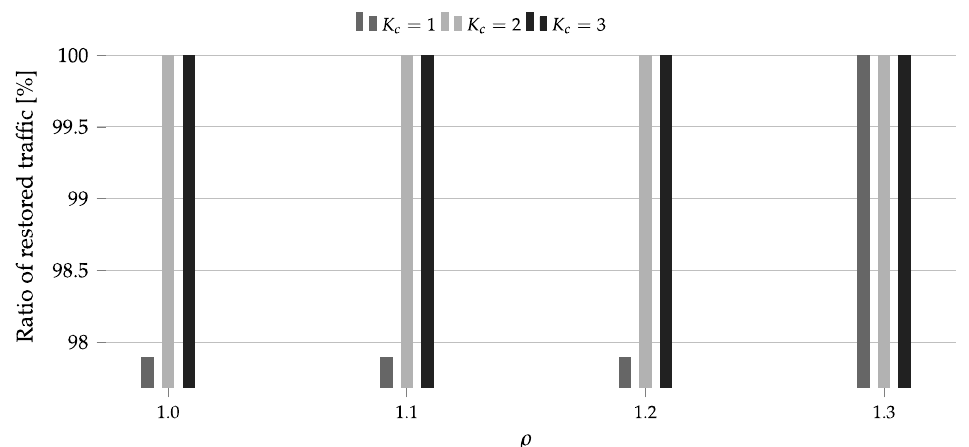
Figure 6. Ratio of the restored traffic for DT14 and 5 Tbps as a function of the amount of additional resources ρ .